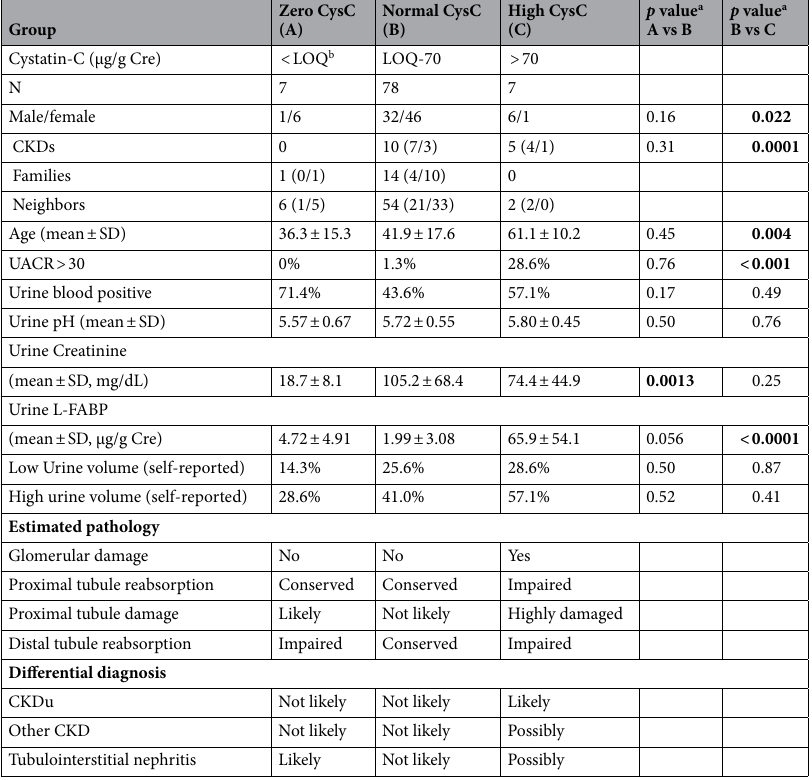
Not likely Possibly Table 7. Demographic data of three groups classified by Urinary Cystatin-C concentration. a Chi-square test for categorical data, and t-test for numerical data; b LOQ of Cystatin-C was 0.01 μg/L.